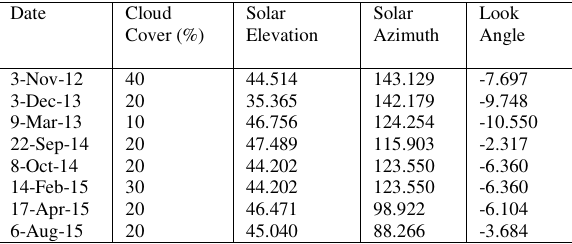
Table 1: Hyperion Satellite images acquired for the retrieval of fluorescence signal. Figure 1 shows the Hyperion image over Hong Kong region. 10 sample sites were also shown over the image at different sites in the Hong Kong country parks.